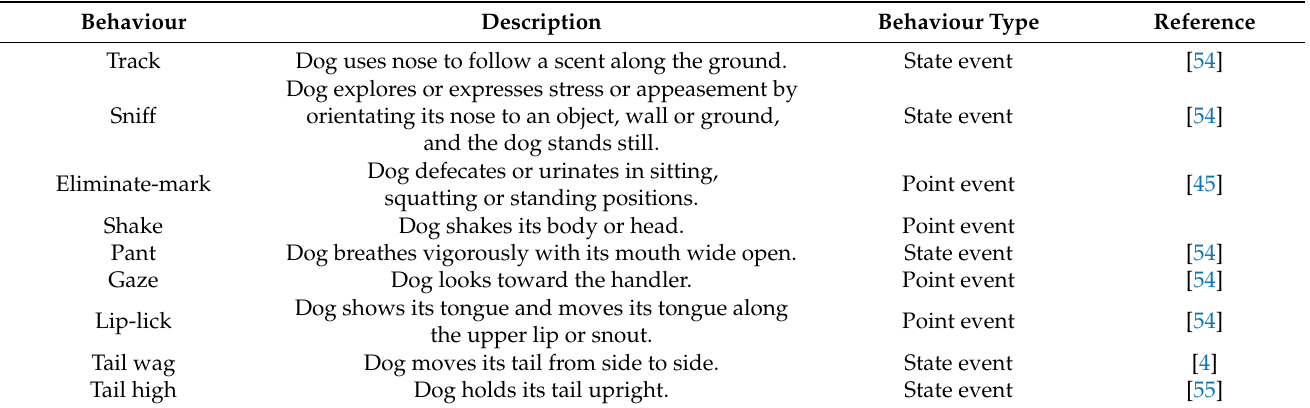
Table 2. Ethogram of canine behaviour